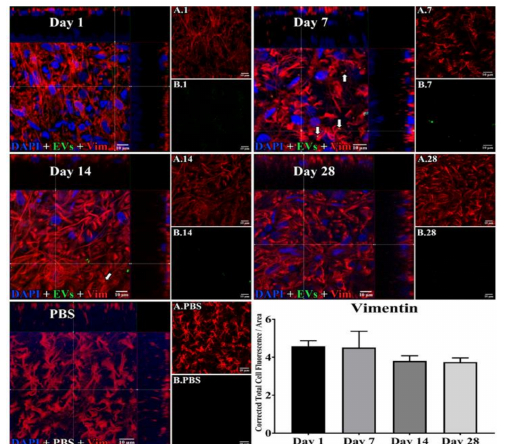
Figure 3. Staining for EVs in astrocytes in flat mounts of rat retinas. The results show that EV staining in astrocytes remained constant after intravitreal injection of EVs. Fluorescent colors are as follows: anti-vimentin (red), EVs (green), DAPI (blue). Orthogonal 3D projection shown as a composite for each day’s panel, and red channels (A.1, A.7, A.14, A.28) and green channels (B.1, B.7, B.14, B.28) for a representative z-stack alongside each day’s composite. PBS injected control is bottom left; A.PBS is red channel, and B.PBS is green channel. Scale bars (10 µ m) are on the bottom right of each panel. Arrows = overlap (co-localization, yellow or yellow-orange) of green EVs and anti-vimentin in astrocytes. 100x. Bottom right: green fluorescence intensity (Y axis) was expressed relative to background. N = 4 per time